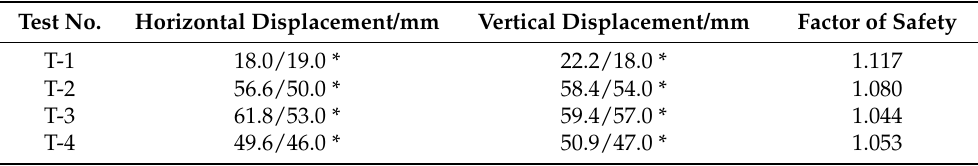
Table 4. Test results of numerical analysis. Test